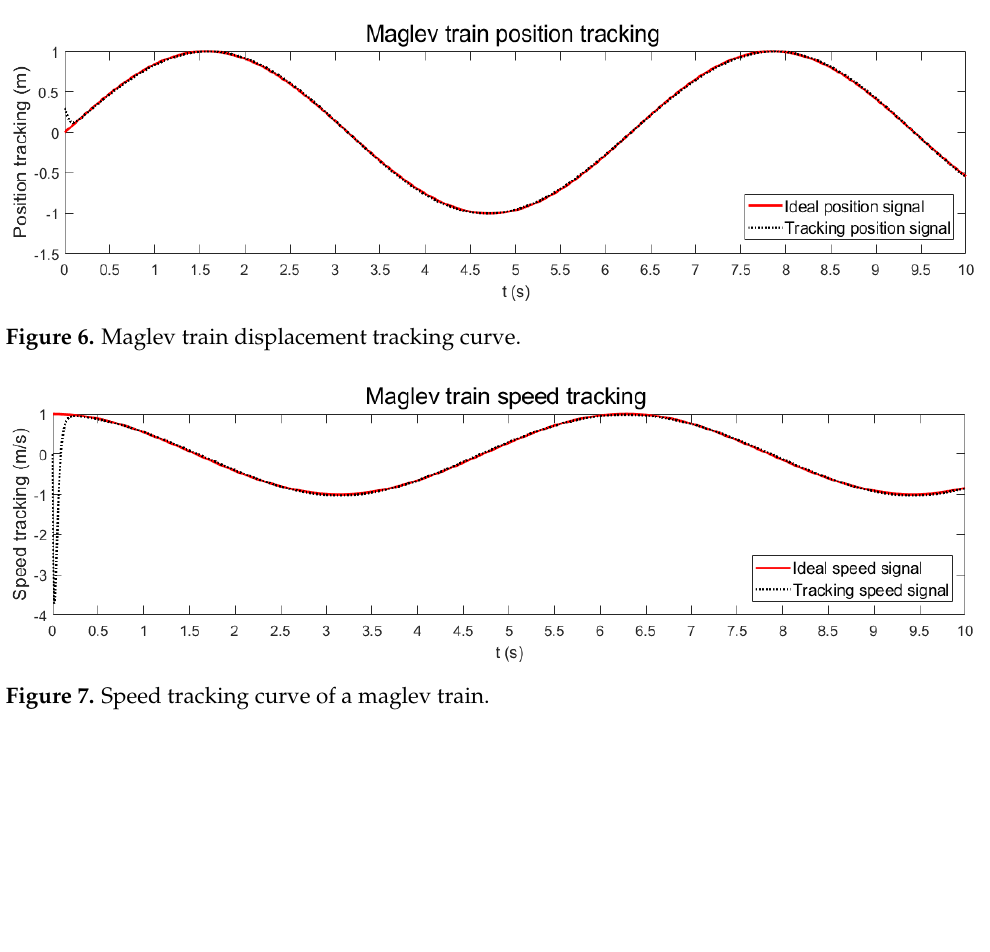
Figure 5. Simulation model.